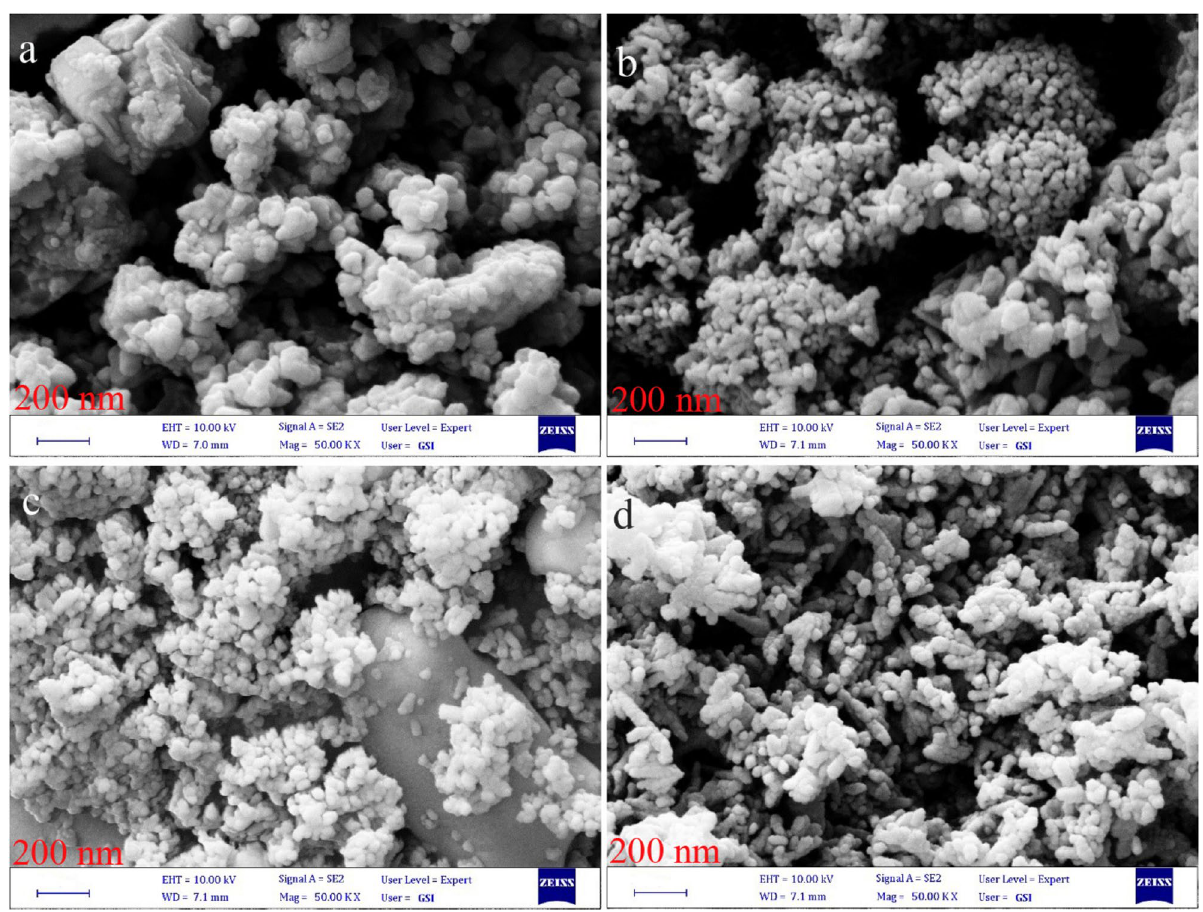
Figure 7. SEM images for as-prepared nanostructures including ( a ) Cu–BaSO 4 –BaTiO 3 , ( b ) Fe–BaSO 4 – BaTiO 3 , ( c ) N–BaSO 4 –BaTiO 3 and ( d ) S–BaSO 4 –BaTiO 3 modified by